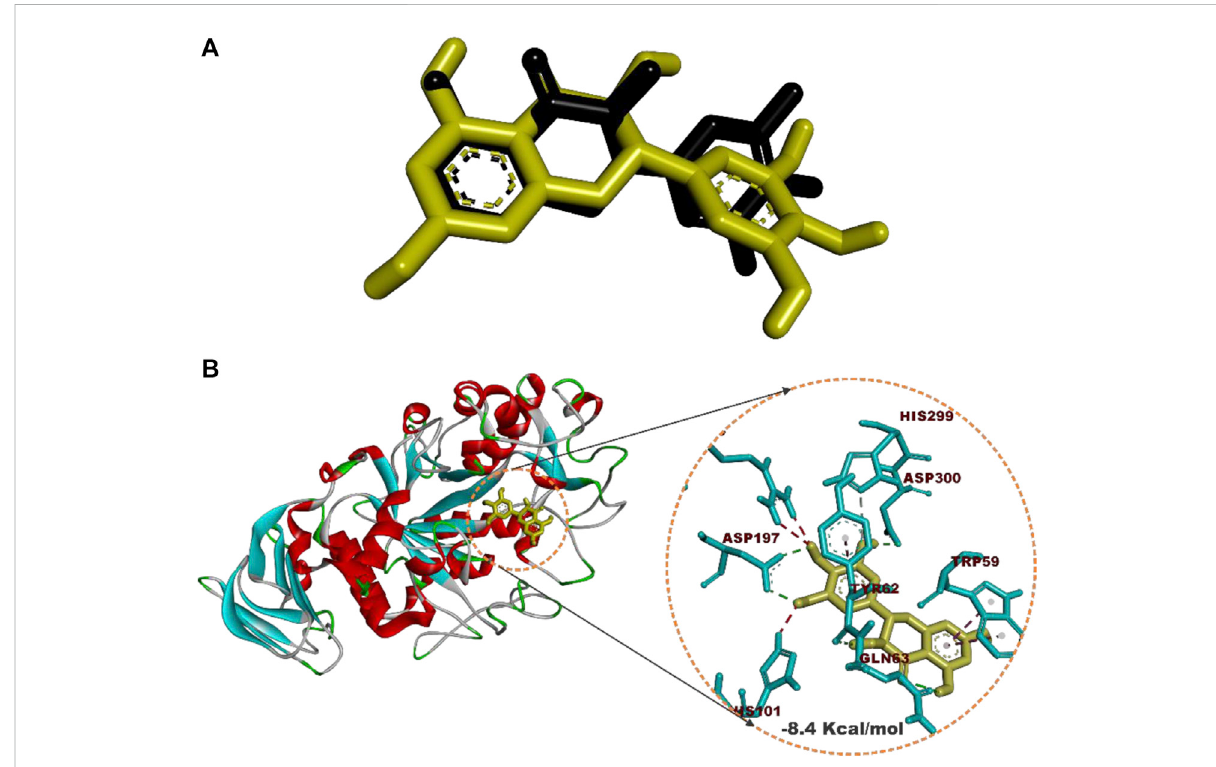
FIGURE 4 Redocked native compound: (A) Superimposition of selected docked conformer of co-crystallized myricetin on the retracted co-crystallized structure. (B) interacted amino acid residues with myricetin.